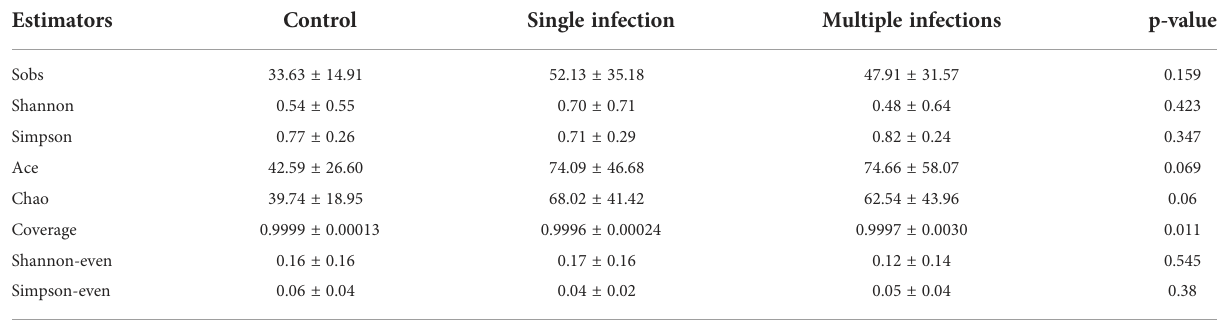
TABLE 3 The a -diversity of the vaginal microbial community compound at the genus level.